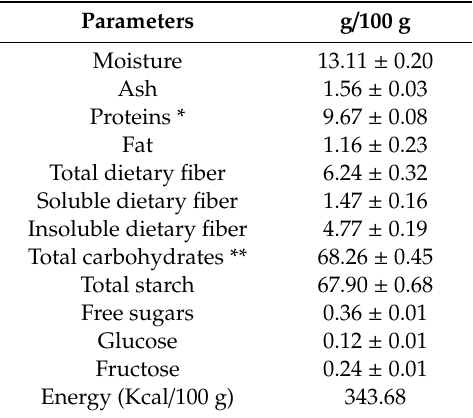
Table 1. Nutritional composition of teosinte